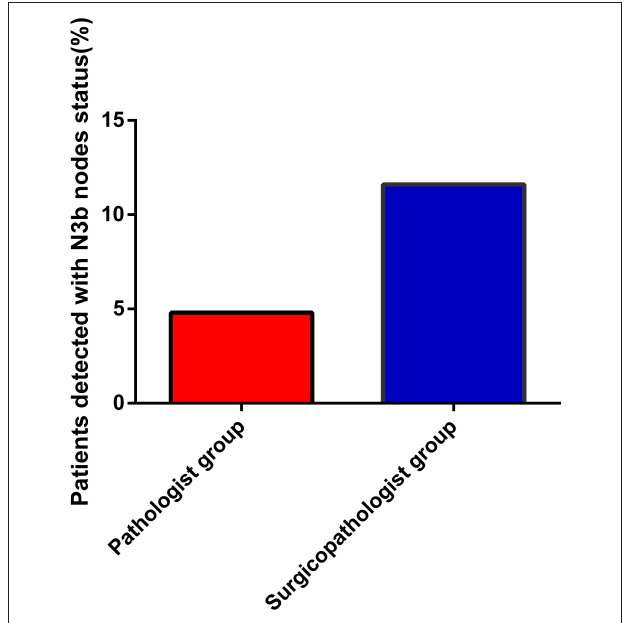
FIGURE 4 | The rate of detecting N3b status between the pathologist group and surgicopathologist group.